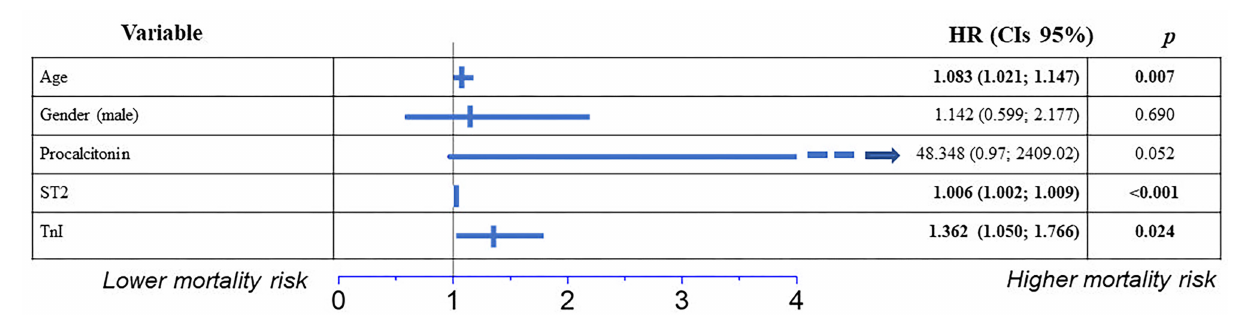
part atypical clinical presentation of dyspnea in COVID-19 patients